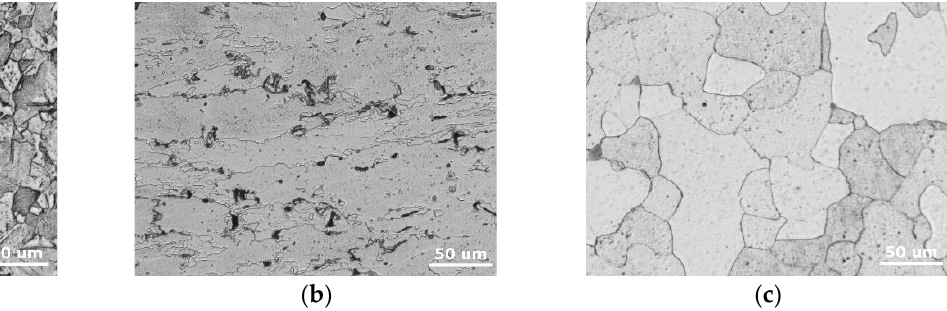
Figure 1. Microstructures of tested materials: ( a ) OFE copper (plane perpendicular to the extrusion direction); ( b ) Al 2017A; ( c ) Armco iron.